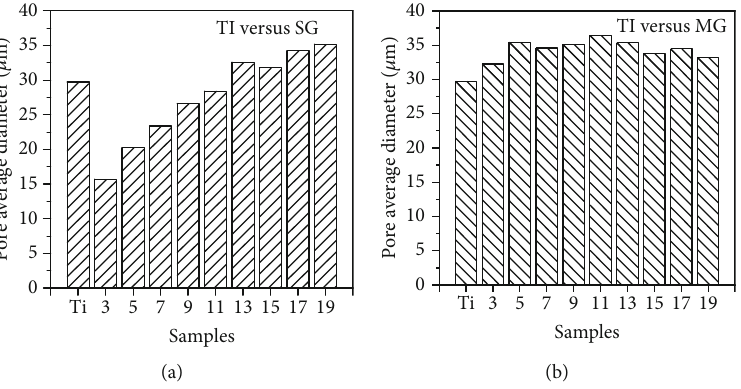
Figure 5: Average pore diameter of the simulation realizations: (a) single grid; (b) multiple